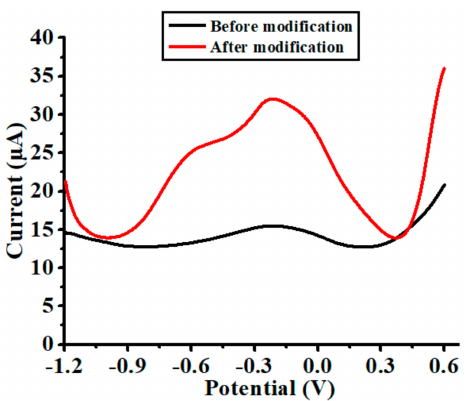
Figure 3. Cyclic voltammograms recorded for the nanoparticles-modified chemical sensor in the solution of 0.1 M acetate buffer, where scan rate is 50 mV/s.